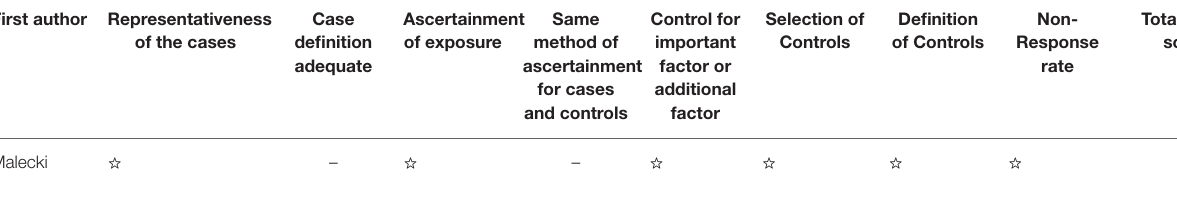
TABLE 2 | Quality assessment of the case-control and cohort studies.